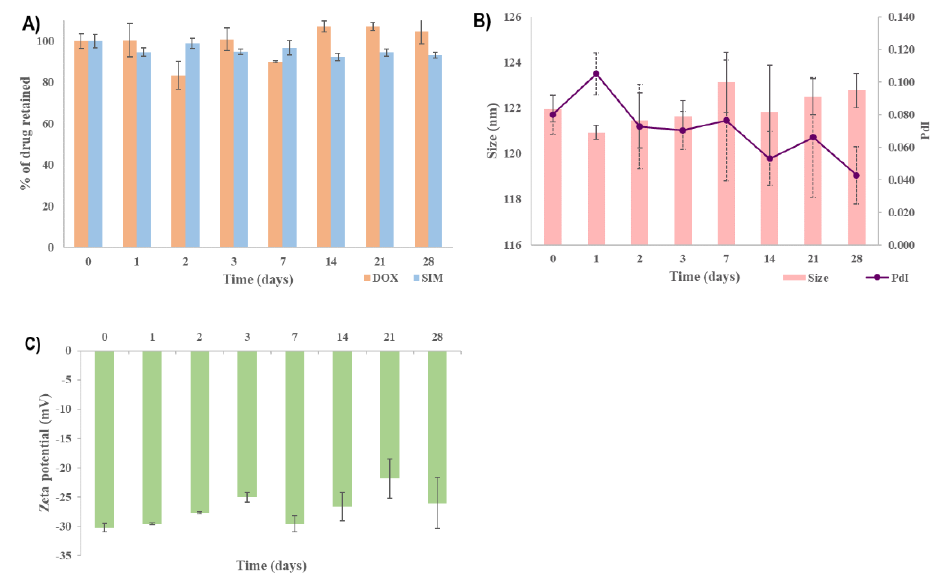
Figure 9. The stability of SIM-DOX-LCL optimal formulation: The % of drug retained ( A ); liposomal size and PdI ( B ); zeta potential ( C ).